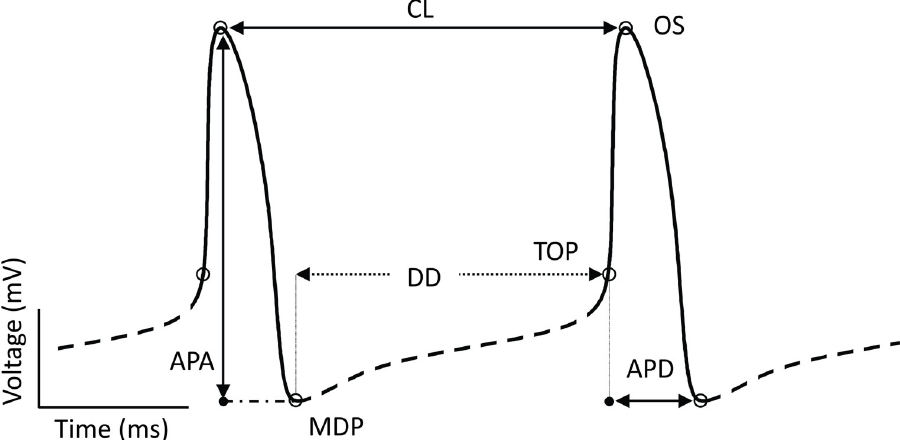
Fig 2. Features extracted from sinoatrial node AP simulations. A schematic AP trace is annotated with characteristic features. The full waveform is divided into the AP phase (solid line) and diastolic phase (dashed line) based on the criteria described. Critical voltages and durations are defined as labeled. Abbreviations: APA, action potential amplitude (mV); APD, action potential duration (ms); CL, cycle length (ms); DD, diastolic depolarization (ms); MDP, maximum diastolic potential (mV); OS, overshoot (mV); TOP, take off potential